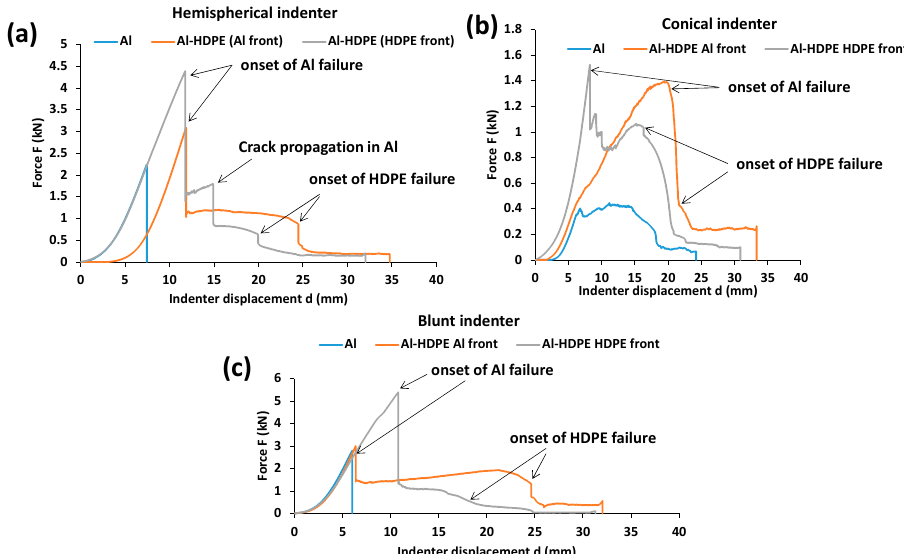
Figure 6. Quasi-static force-displacement profile of bilayer laminates under ( a ) hemispherical, ( b ) conical and ( c ) blunt indenters.